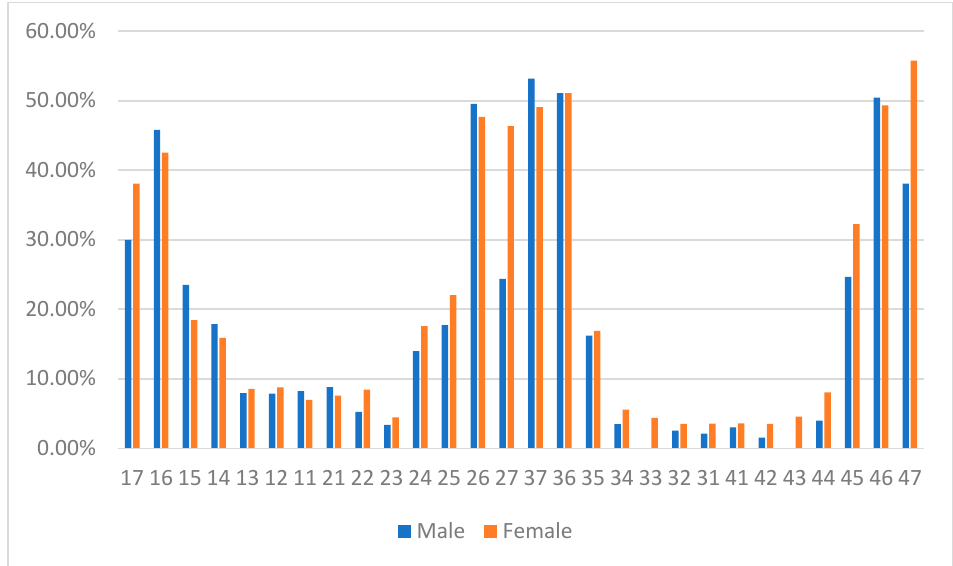
Figure 1. Distribution of dmft according to the tooth type .